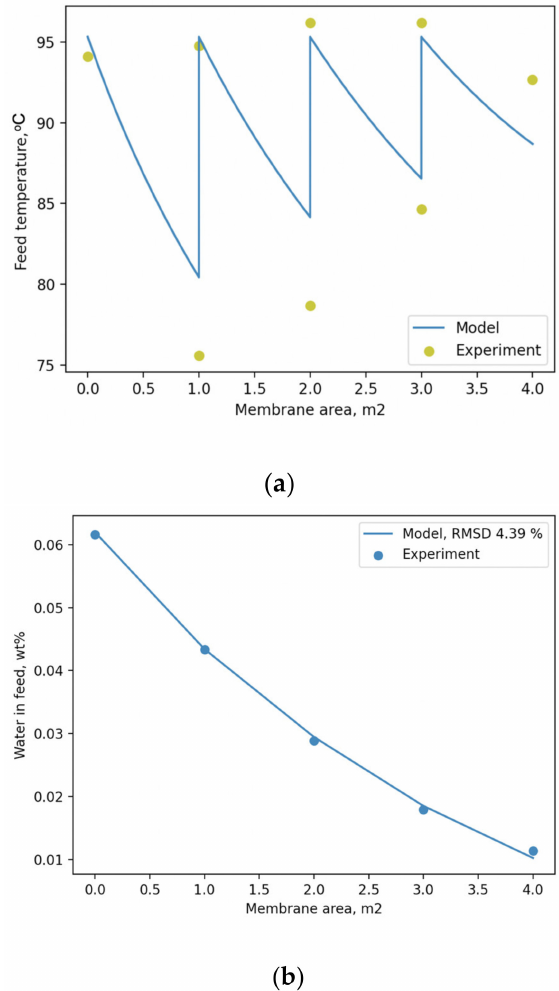
Figure 7. Illustration of modelling a non-isothermal non-ideal process described in [45] with PyVapo- ration (curves), along with the corresponding experimental results (dots); ( a ) feed temperature as a function of membrane area; ( b ) weight fraction of water in feed as a function of membrane